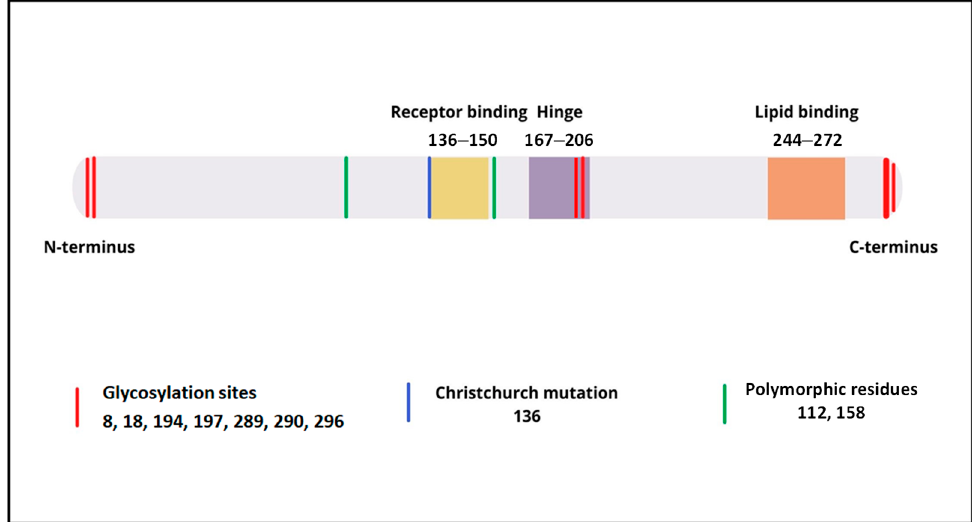
Figure 1. Schematic structure of ApoE. Possible O-glycosylation sites: Thr8, Thr18, Thr194, Ser197, Thr289, Ser290 and Ser296 [7]. The Christchurch mutation results in a Arg136–Ser substitution [18]. Cys and/or Arg may be present at the 112th and 158th position in the amino acid chain, which determines the occurrence of the respective isoforms of ApoE [11,15]. Modification based on Liu et al. [22].